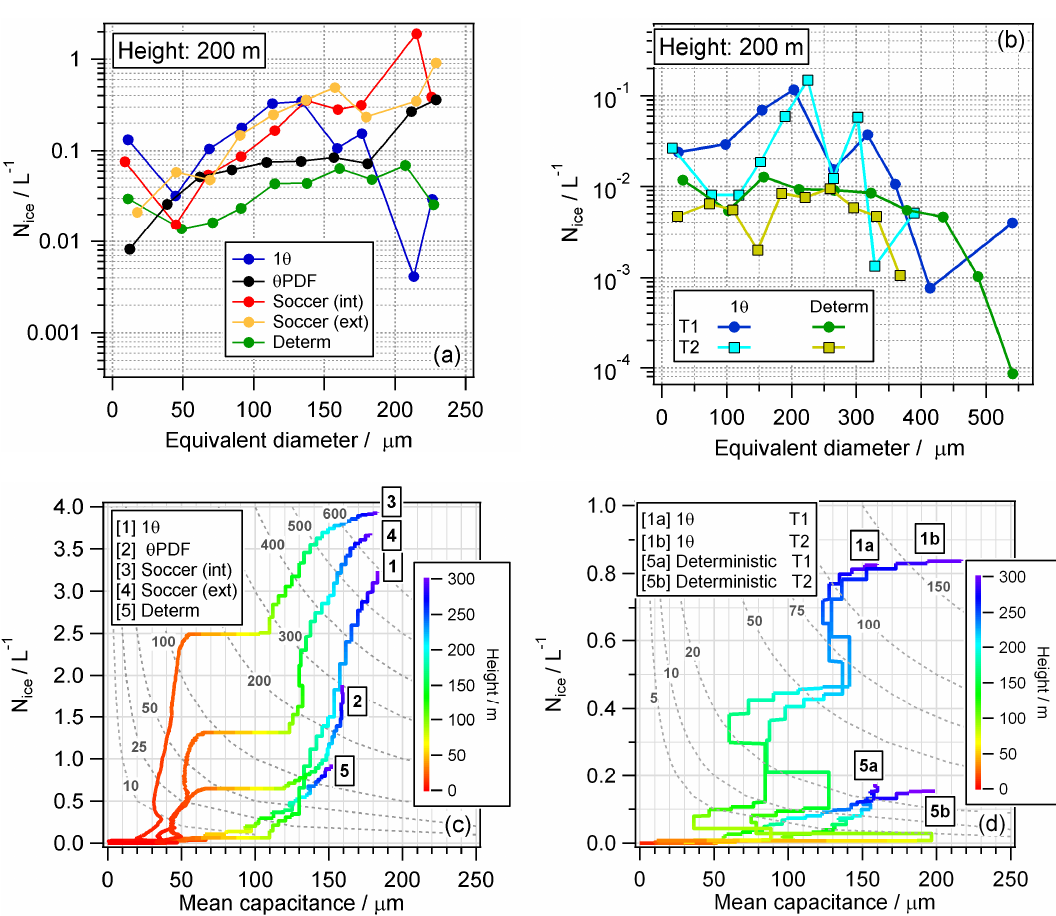
Fig. 9. Parcel model results for polydisperse IN distributions: (a, b) ice size distributions ( h = 200m) and (c, d) details on mean and integral ice capacitance. Grey contours show lines of equal capacitance; numbers on the contours denote integral capacitance N i C i [µml − 1 ]. (a, c) T ∼ 243K (kaolinite). (b, d) Temperature ranges T1 and T2.